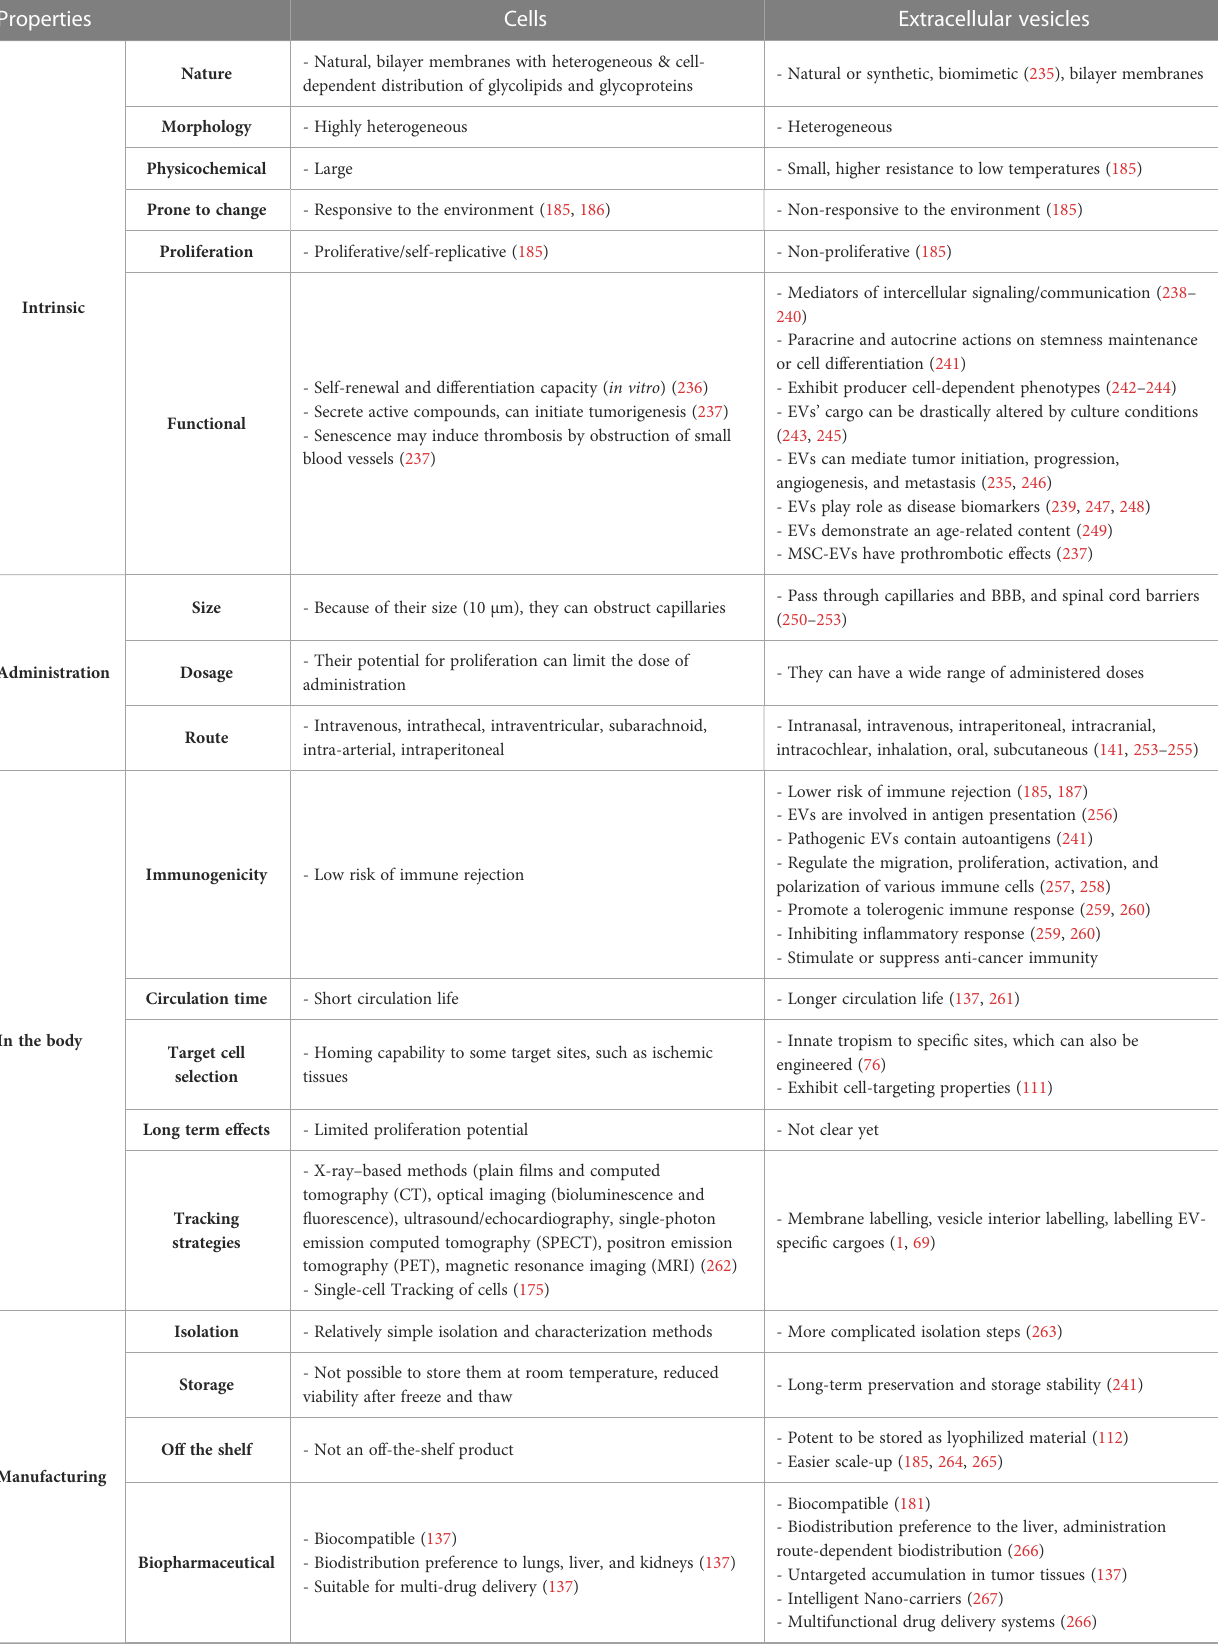
TABLE 2 Comparison between the cells and EVs regarding their intrinsic and application